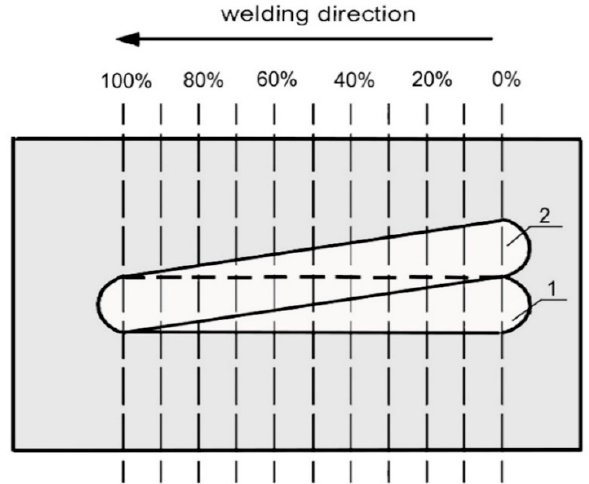
Figure 1. Scheme of the temper bead welding (TBW) technique specimen, 1—first (tempered) padding weld, 2—second (tempering) padding weld.